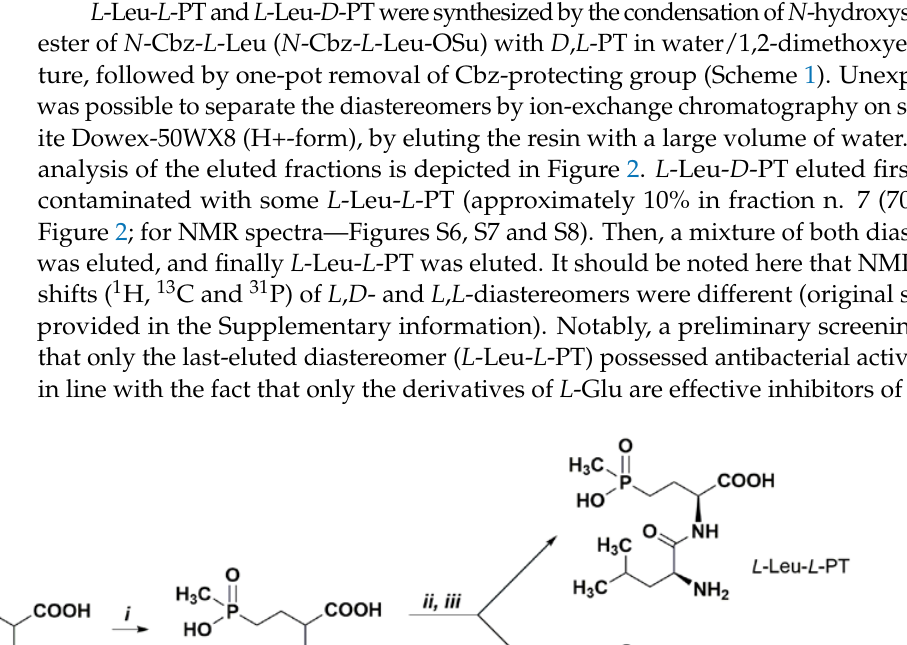
Figure 1. Chemical structures of L -phosphinothricin ( L -PT), L -leucyl- L -phosphinothricin ( L -Leu- L - PT) and L -phosphinothricyl- L -alanyl- L -alanine (Bialaphos, L -PT- L -Ala- L -Ala).